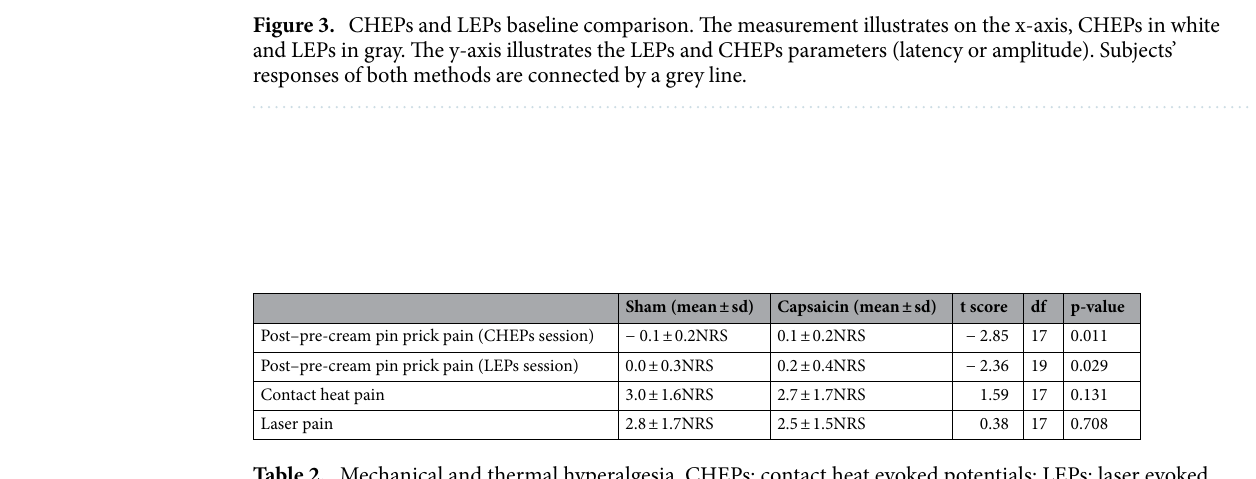
Table 2. Mechanical and thermal hyperalgesia. CHEPs: contact heat evoked potentials; LEPs: laser evoked potentials; df: degree of freedom; sd: standard